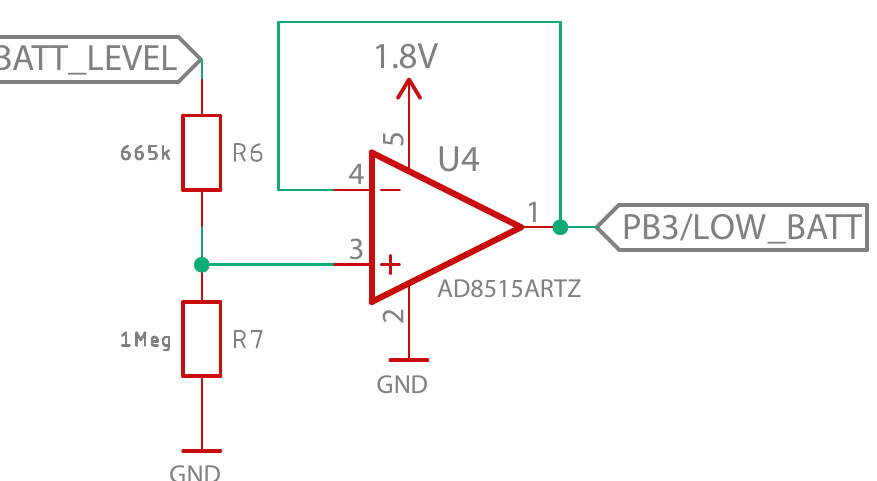
Figure 8. Power supply stage schematic design.